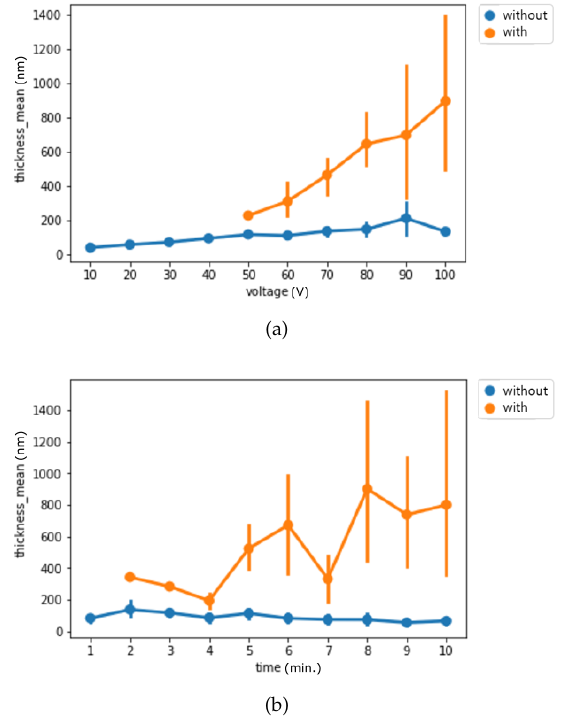
Figure 3. ( a ) Binary classification result by voltage from 10 V to 100 V ( b ) Binary classification result by time from 1 min to 10 min (line indicates 95% CI).